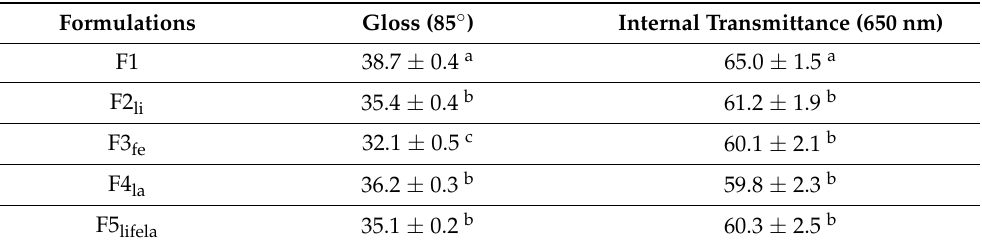
Table 4. Mean and standard deviation of brightness ( ◦ ), internal transmittance (nm), of the different films after one week at 53% relative humidity and 25 ◦ C.